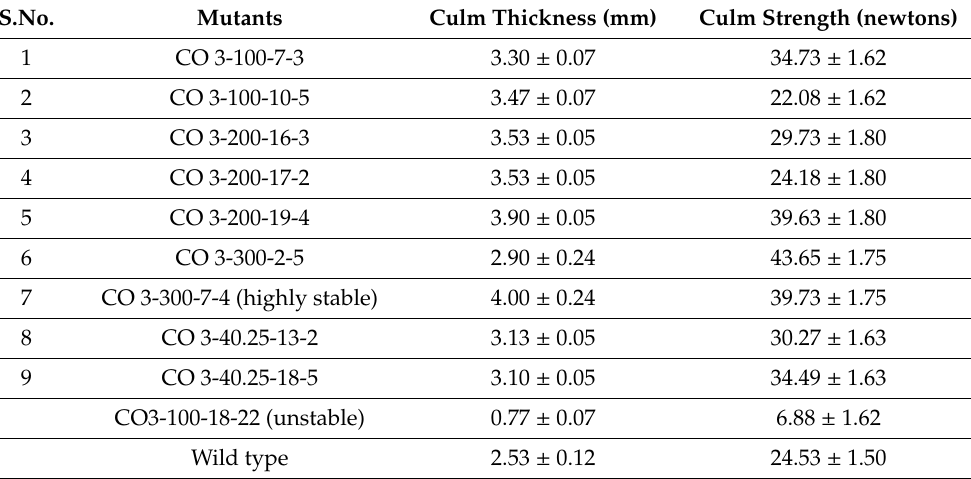
Table 3. Mutants screened for lodging trait in M 2